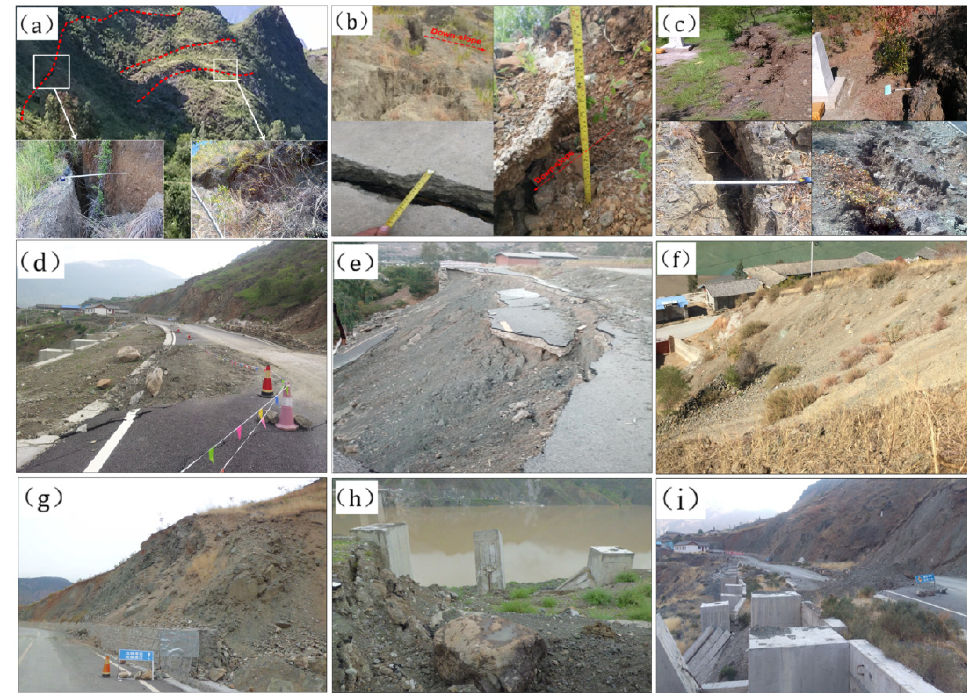
Figure 14. Field investigation images of the XJ landslide. ( a – i ) are the field investigation photos of XJ landslide.